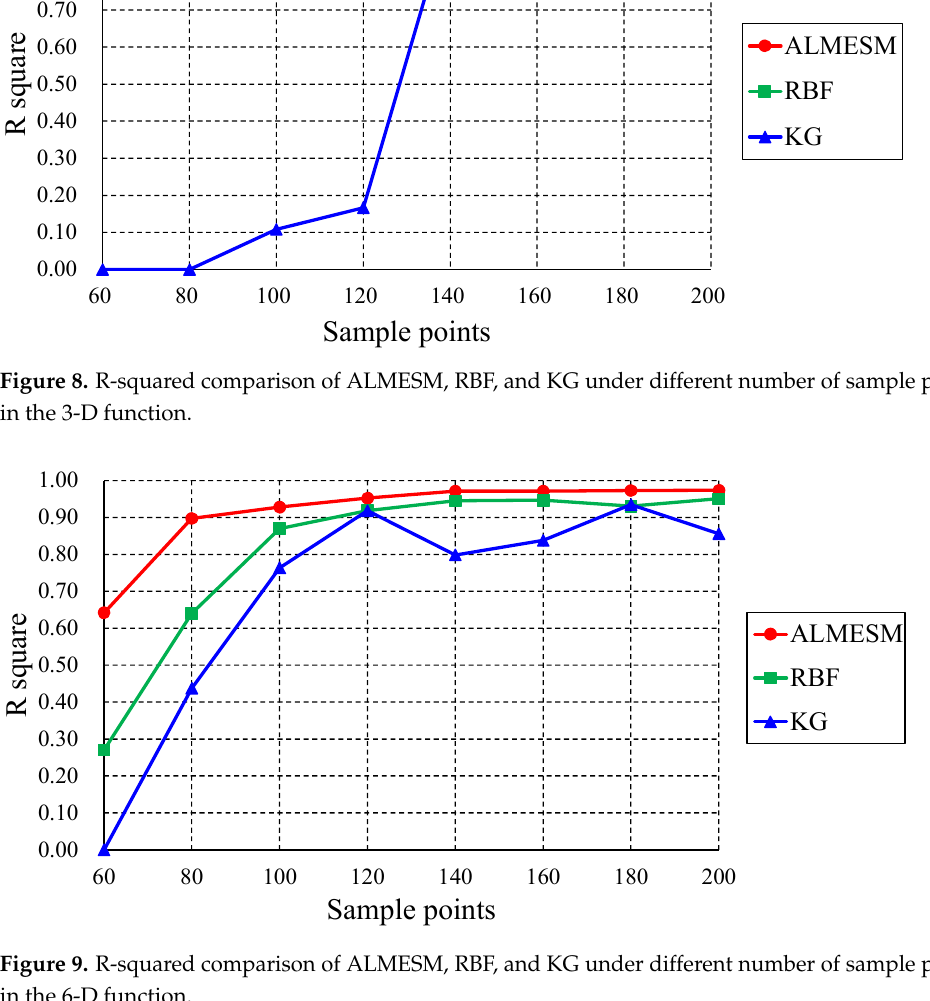
points in the 6-D function. in the 6-D